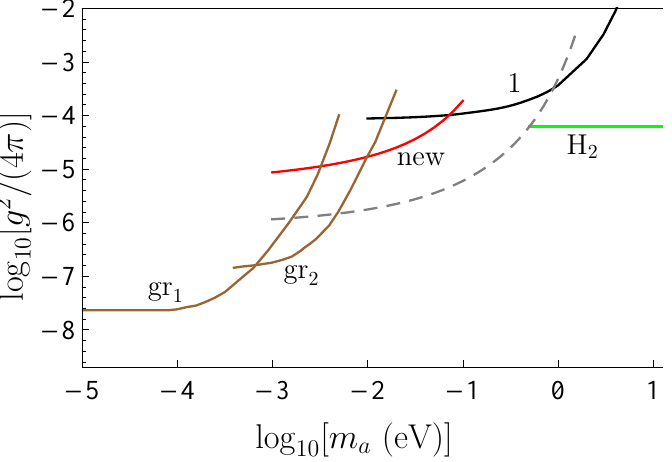
Figure 1. The strongest constraints on the coupling constant of axionlike particles to nucleons obtained from different experiments. Lines labeled “gr 1 ” and “gr 2 ” are found from the Cavendish- type experiments and from measuring the minimum gravitational forces, respectively. Lines labeled “new” and “H 2 ” follow from the recent experiment on measuring the Casimir force in the micrometer separation range and from the experiment using a beam of molecular hydrogen. Line 1 and the dashed line are obtained from measuring the effective Casimir pressure and from the experiment nullifying the Casimir force. The regions above each line are excluded, and those below are